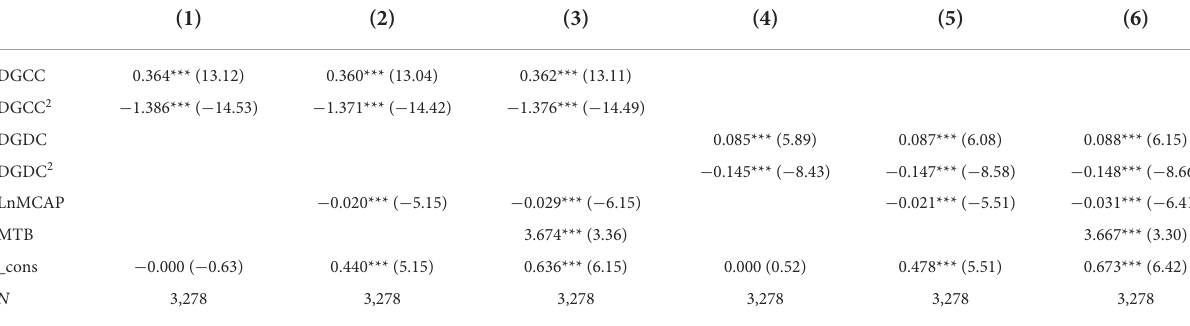
TABLE 10 Changing trend of the COVID-19’s impact on the stock returns in cultural